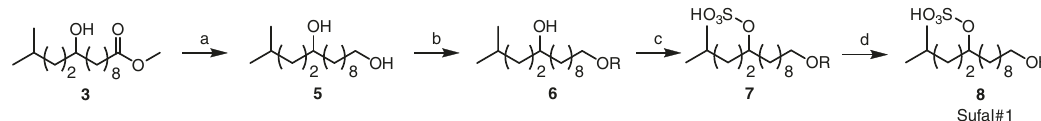
Fig. 6 Overview of synthesis of sufal#1. Reagents and conditions: a LiAlH 4 , THF; b t -butyldiphenylsilyl chloride (TBDPS-Cl), imidazole, THF; c SO 3 /pyridine complex, pyridine; d acetyl chloride, MeOH